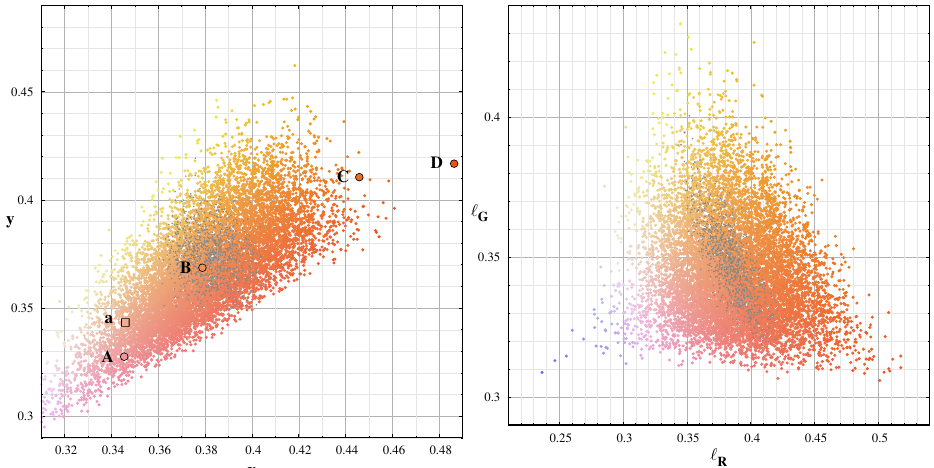
Figure 11. Correlated colour temperature (CCT)-colour diagram of the learning set: (cid:96) G as a function of CCT. The dots represent the actual colours.